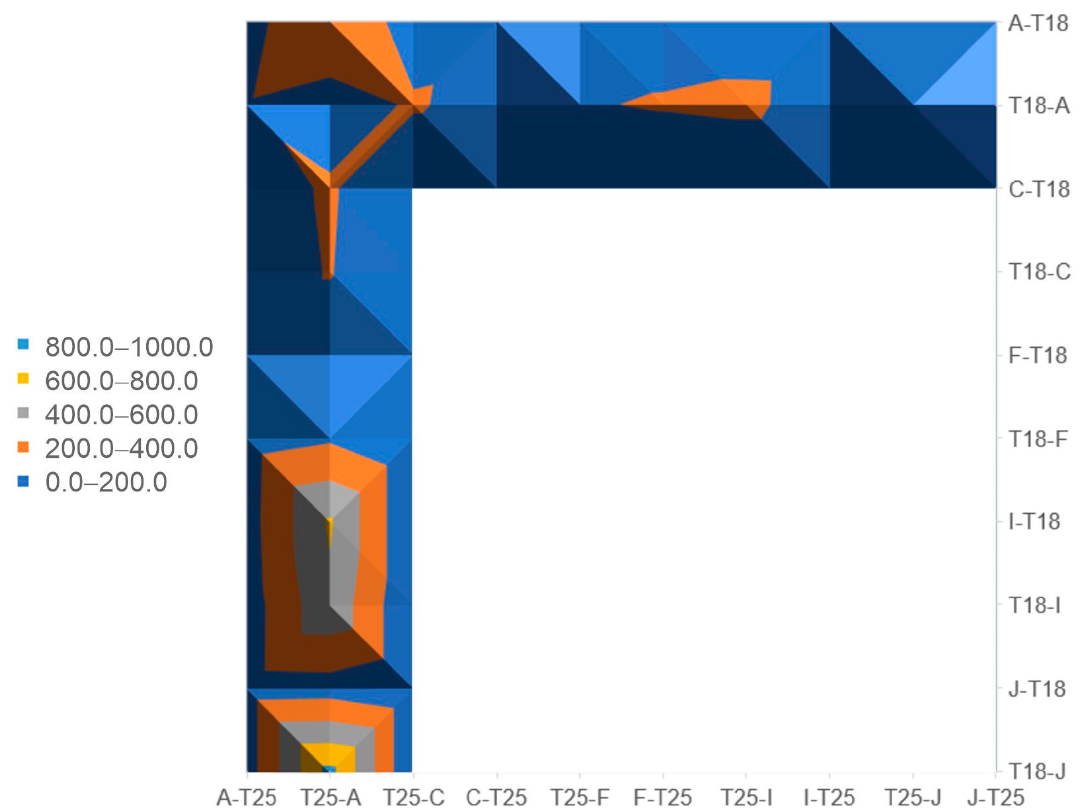
Figure 5. Bacterial two-hybrid screening for PssA interactions with other glycosyltransferases and components of the polymerization and export system of exopolysaccharide in R. leguminosarum bv. trifolii . The surface diagram includes only those protein-protein pairs tested, where activities twice as high as the values for the negative controls were observed at least in one of eight possible combinations of fusion proteins. β -galactosidase activities of negative controls [pUT18(pUT18C) × pKT25(pKNT25)] ranged from 90.7 ± 4.9 to 98.9 ± 2.1. Ranges of activity values in the graph refer to Miller units. Activity values ± SD for all the tested fusion proteins pairs were given in a Supplementary Figure S3.